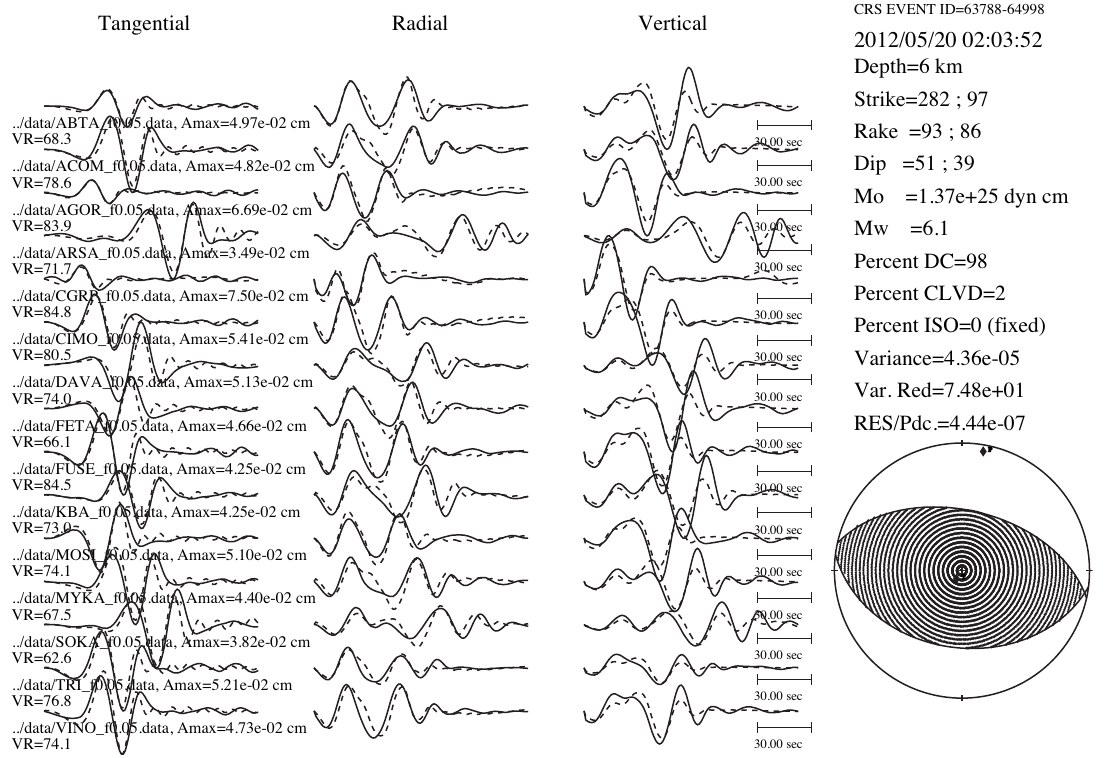
6.1). Details about the stations can be found on the OGS- W